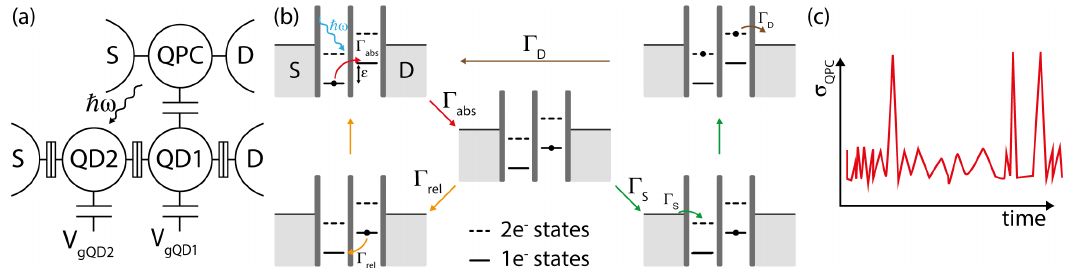
Figure 3. ( a ) Noise detection scheme based on quantum dots (QDs). The quantum point contact (QPC), which is capacitively coupled to the double quantum dot, acts both as a source of microwave photons and as a charge sensor that probes the configuration of the DQD. ( b ) Scheme of the different paths that the DQD system can take after photon absorption. Γ rel shows the relaxation path, where the electron returns to the ground state, emitting a phonon/photon in the process. Γ S followed by Γ D shows the charging with an additional electron through tunneling from the source contact. In the two-electron state, tunneling out of the device is permitted: this returns the system to the initial configuration. ( c ) Typical time trace of the detector signal. The peaks correspond to entering and leaving of the additional electron in the